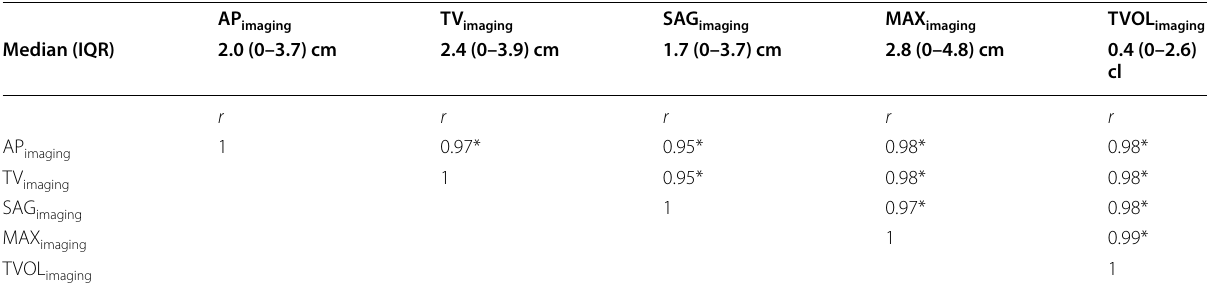
Table 2 Median (IQR) values for MRI‑assessed tumor size variables and their correlations in 416 patients with cervical cancer